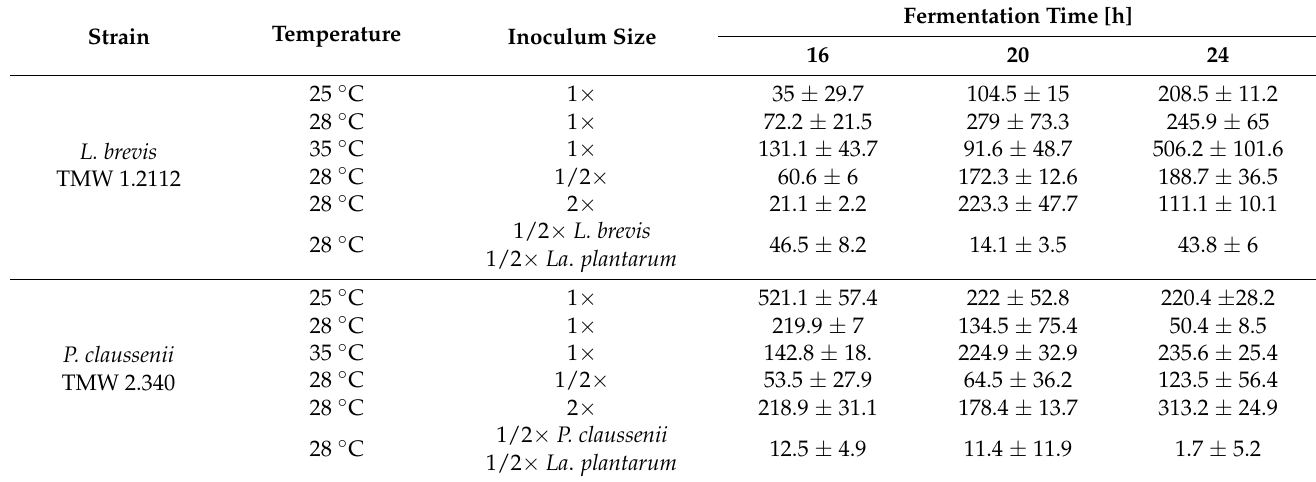
Table 1. β -glucan [mg/kg] production by varying parameters in wheat fermentation by L. brevis TMW 1.2112 and P. claussenii TMW 2.340.